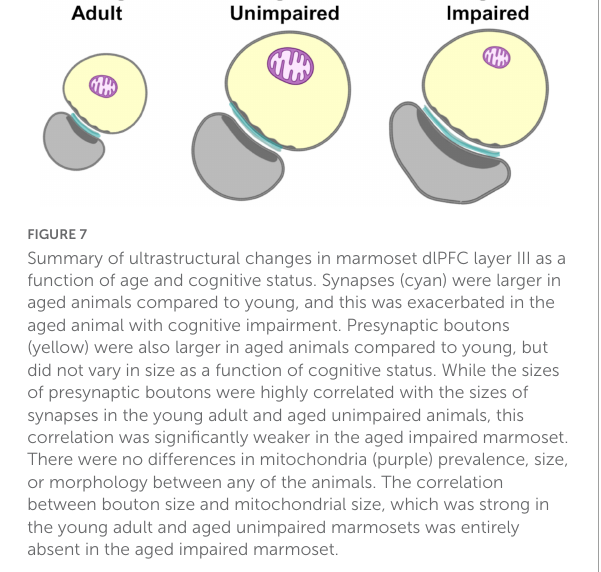
marked (28%) reduction in synapse density compared to